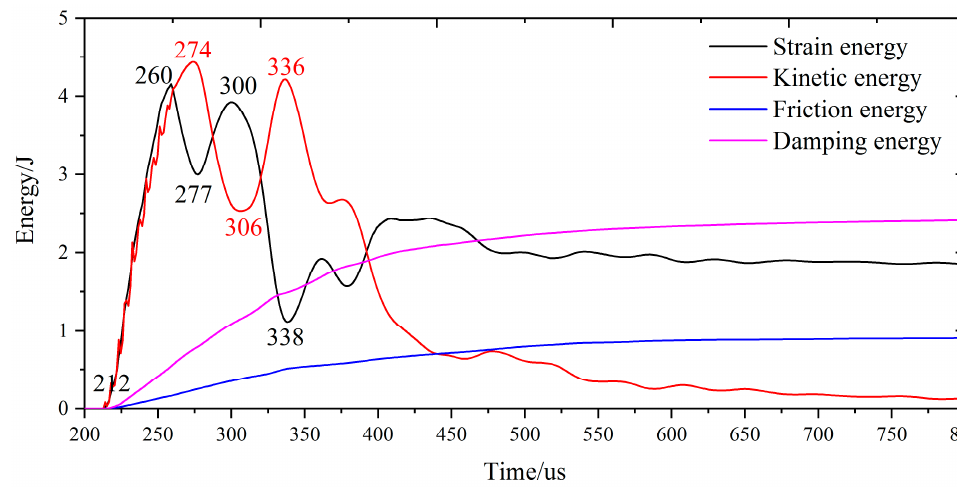
Figure 16. Energy conversion during stress wave incidence.